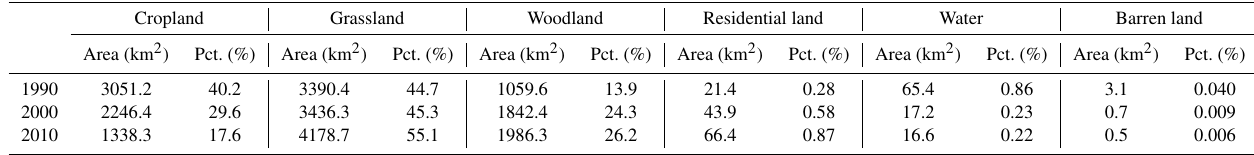
Table 2. Land use changes in the Yanhe Basin from 1990 to 2010. Cropland Grassland Woodland Residential land Water Barren land Area (km 2 ) Pct.